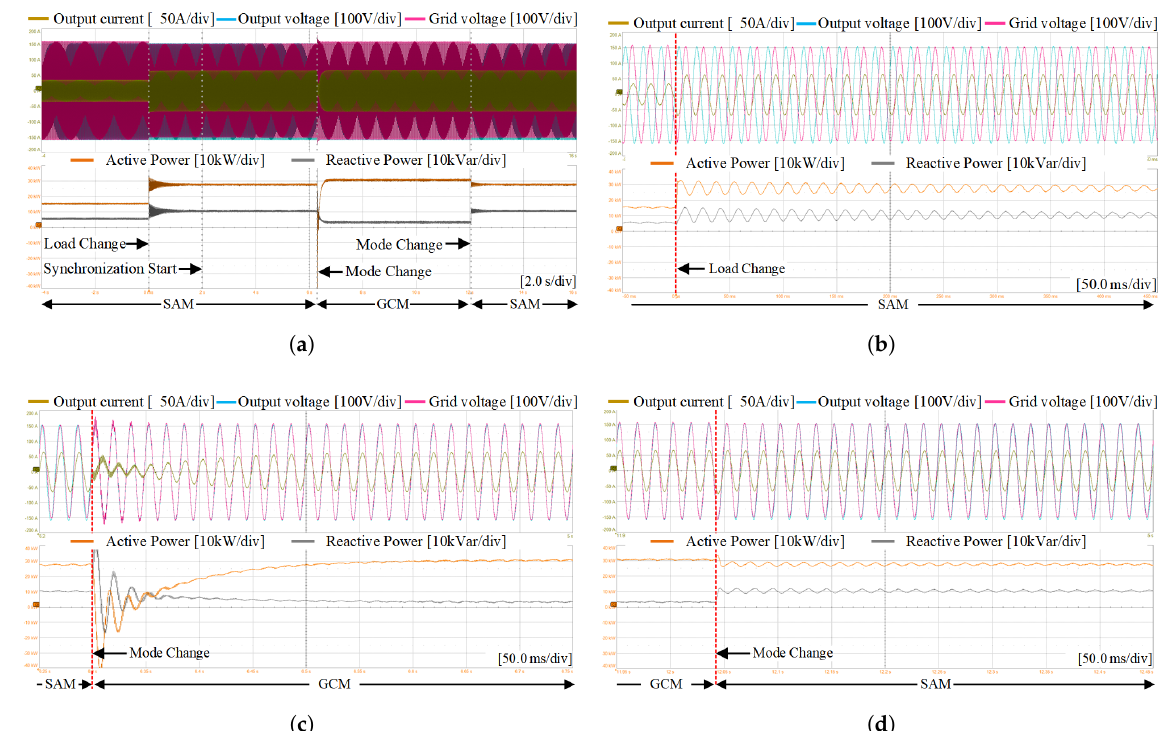
Figure 12. HILS based experimental results of conventional control method with parallel R-L load condition ( a ) overall sequence, ( b ) load step change, ( c ) SAM to GCM transition, ( d ) GCM to SAM